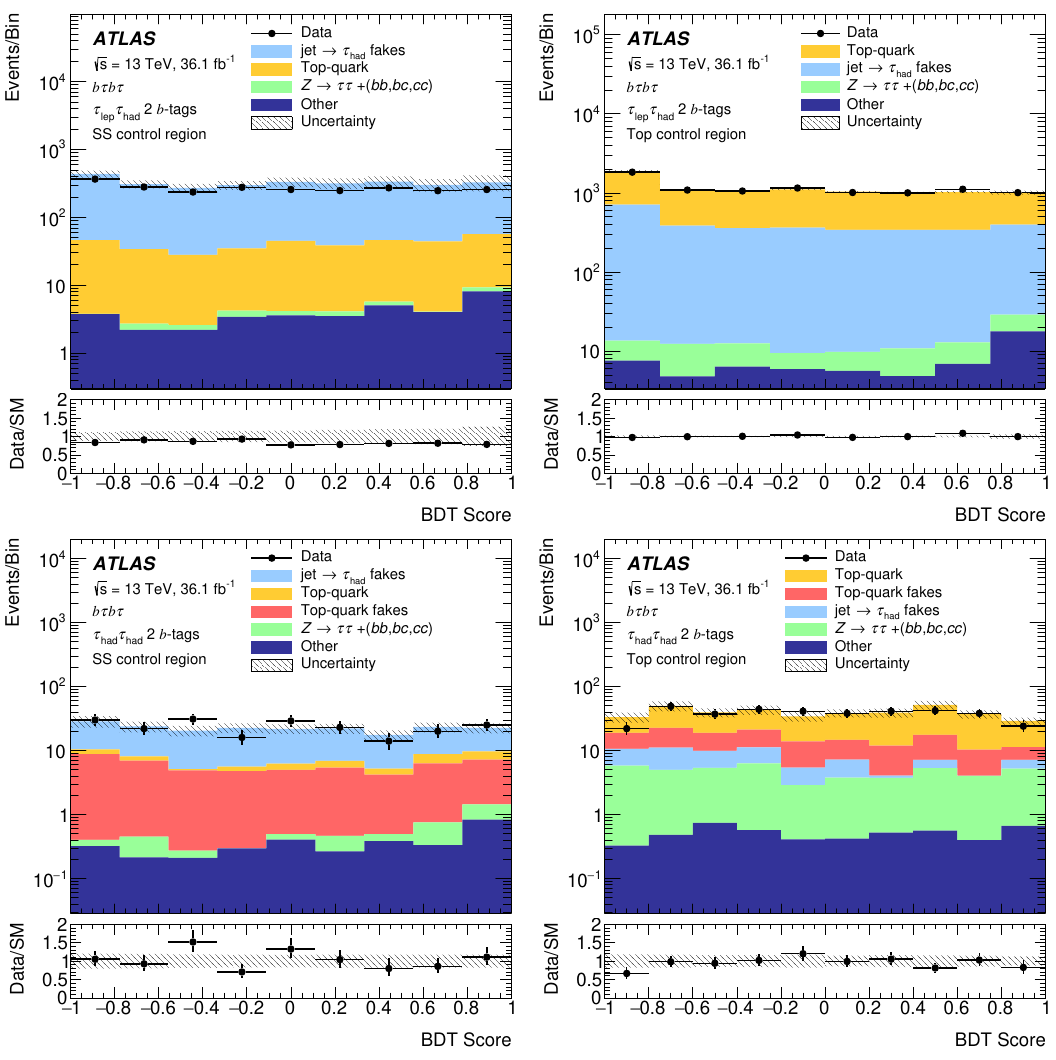
Figure 5 . BDT score distributions for (cid:28) ‘ (cid:28) had (top) and (cid:28) had (cid:28) had (bottom) 2-tag channels in the same-sign (left) and top-quark (right) control regions after performing the combined (cid:12)t to all chan- nels. The ratio of the data to the sum of the backgrounds is shown in the lower panel. The hatched bands indicate the combined statistical and systematic uncertainties in the